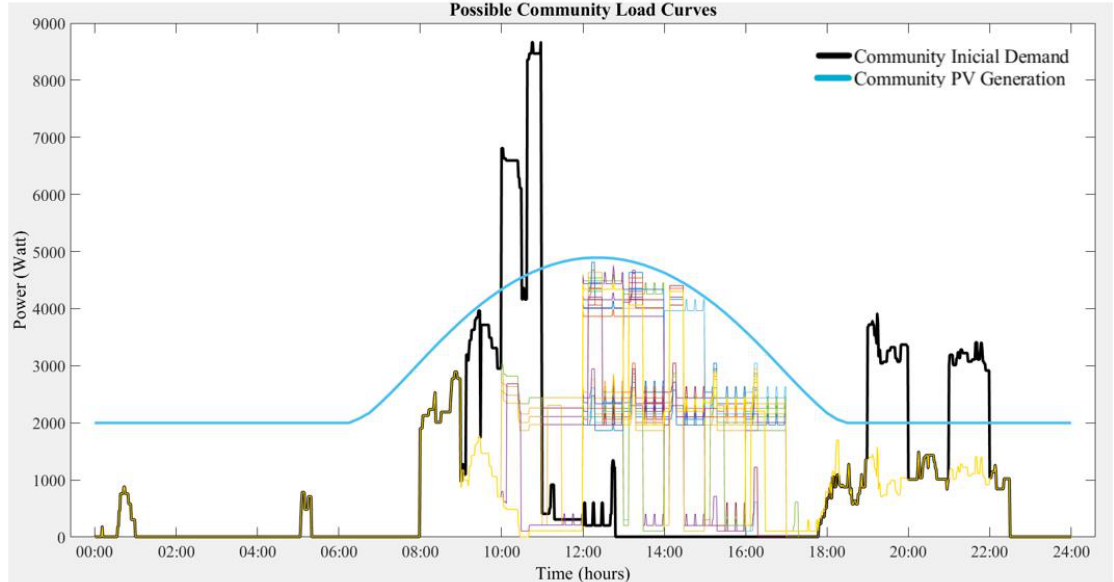
Figure 16. Possible solutions for the community’s demand profile regarding Scenario 2.